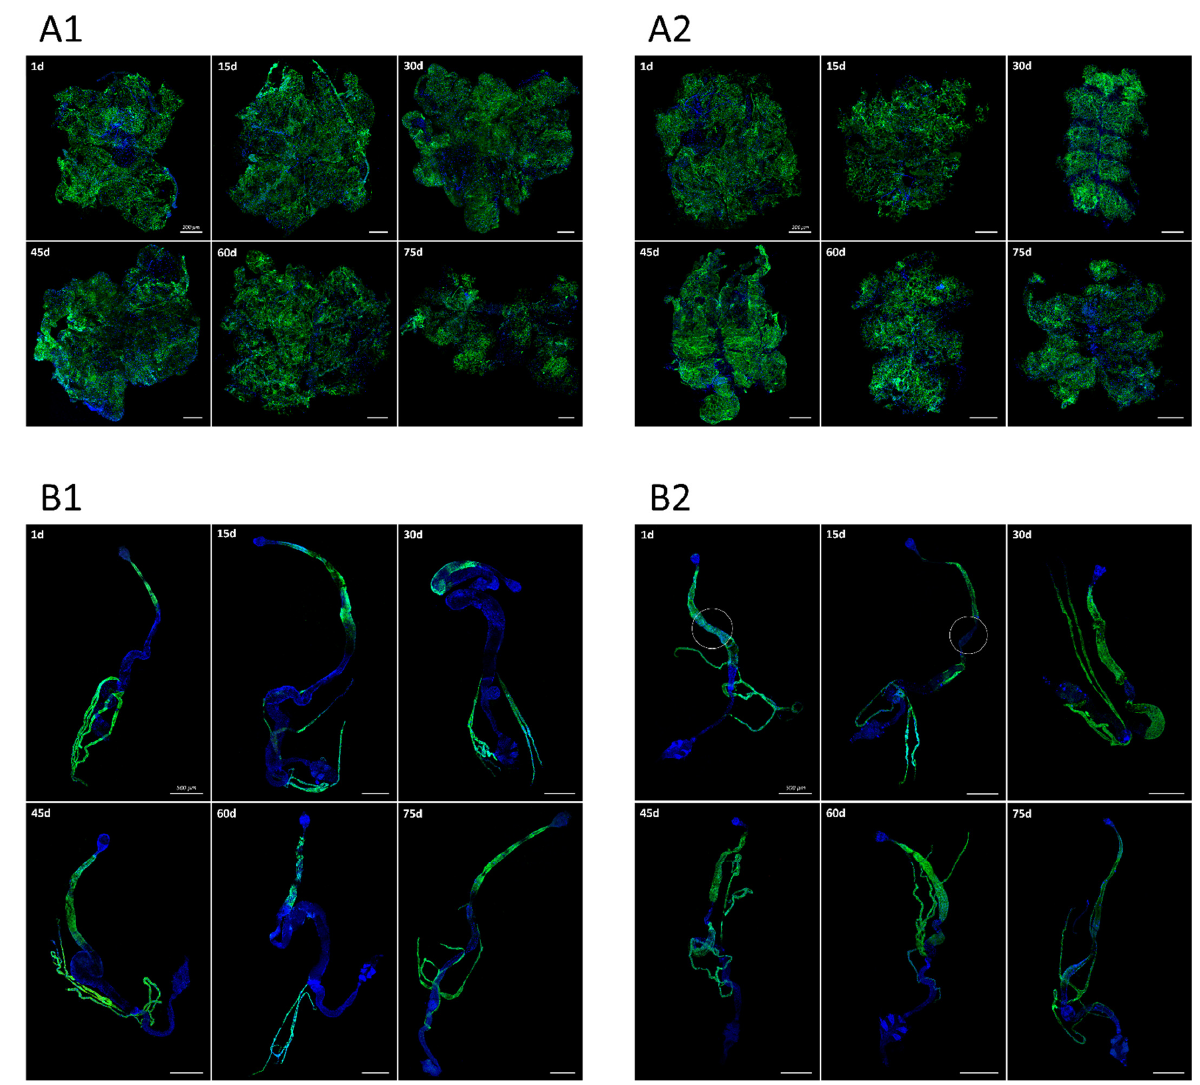
Figure 2. The cells with GFP (green) expression in the organs of imagoes with sws-GAL4;UAS-CD8-GFP genotype. ( A ) Fat body, ( B ) intestine and Malpighian tubes of ( A1 , B1 ) males and ( A2 , B2 ) females. Nuclei are stained with DAPI (blue). In the left upper corner of each photograph, the age of imago (days) is written. Scale bar: ( A )—200 µm, ( B )—500 µm.